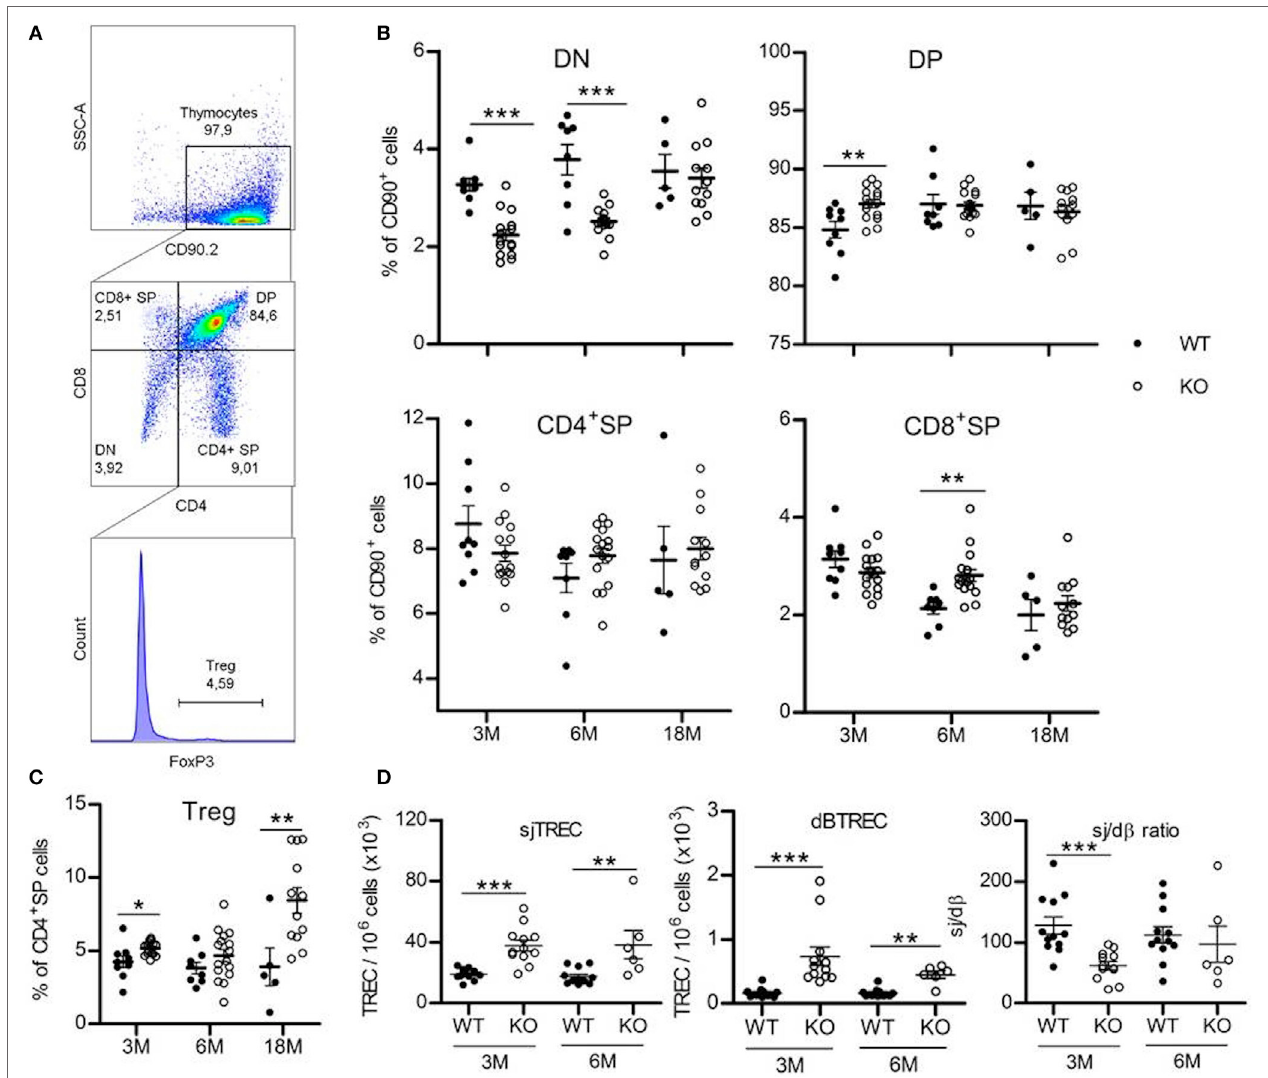
FigUre 1 | Thymus phenotype and function. (a) Representative flow cytometry plots showing the four thymic subpopulations double-negative (DN) (CD4 − CD8 − ), double-positive (DP) (CD4 + CD8 + ), CD4 + single-positive (SP) (CD4 + CD8 − ), and CD8 + SP (CD4 − CD8 + ) cells, identified within the CD90.2 + population. FoxP3 + Treg cells are studied inside the CD4 + SP population. 30,000 events are recorded. (B,c) Frequencies of the four thymic T-cell subpopulations (B) and FoxP3 + Treg cells (c) in thymus of KO (white circles, n = 12–16) and wild-type (WT) (black circles, n = 5–9) mice at 3, 6, or 18 months. Data (mean ± SEM) are representative of two to three independent experiments. Unpaired t -test was used for statistical analysis. (D) sjTREC, d β TREC, and sj/d β ratio in splenocytes of KO (white circles, n = 12) and WT (black circles, n = 6–12) mice at 3 and 6 months are shown. Data (mean ± SEM) are representative of two independent experiments. Unpaired t -test was used for statistical analysis. *** p < 0.001, ** p < 0.01, * p < 0.05.